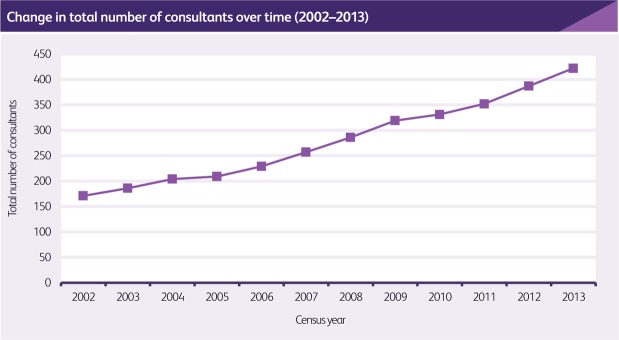
Data provided by the Royal College of Physicians shows a steady increase in the total number of consultant medical oncologists in the United Kingdom growing from just over 150 in 2002 to over 400 in 2013. Reproduced with permission. (Federation of the Royal Colleges of Physicians of the UK. Census of consultant physicians and higher specialty trainees in the UK: specialty reports, 2013–14. London: Royal College of Physicians, 2015: 155 and 157.)